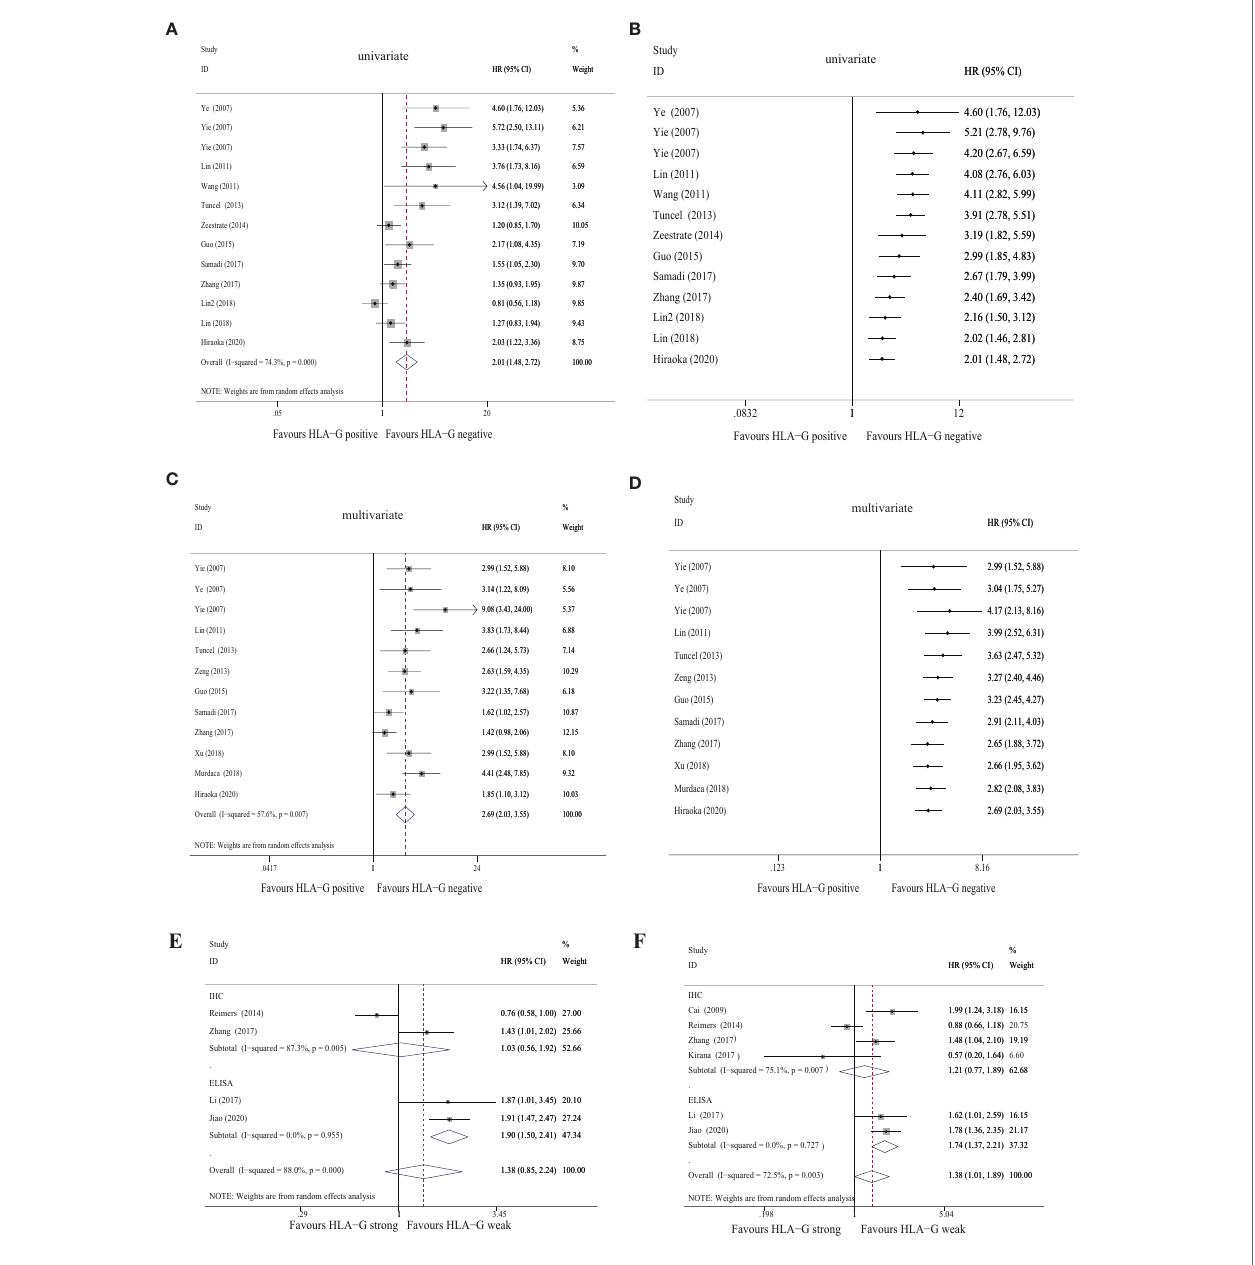
stage disease (OR = 0.30, 95% CI: 0.17 ~ 0.53, P = 0.716, I 2 = 0%), advanced tumor status (OR = 0.11, 95% CI: 0.04 ~ 0.30, P = 0.926, I 2 = 0%), and positive nodal status (OR = 0.36, 95% CI: 0.18 ~ 0.69, P = 0.747, I 2 = 0%) in ESCC patients, but no signi fi cant association was observed in other cancers ( Supplementary Figure S2 ). For the HLA-G antibody subgroup analysis, HLA-G expression detected by the HGY antibody was signi fi cantly correlated with clinical stage, tumor status, and nodal status ( P < 0.050), while HLA-G expression detected by the 4H84 antibody was only related